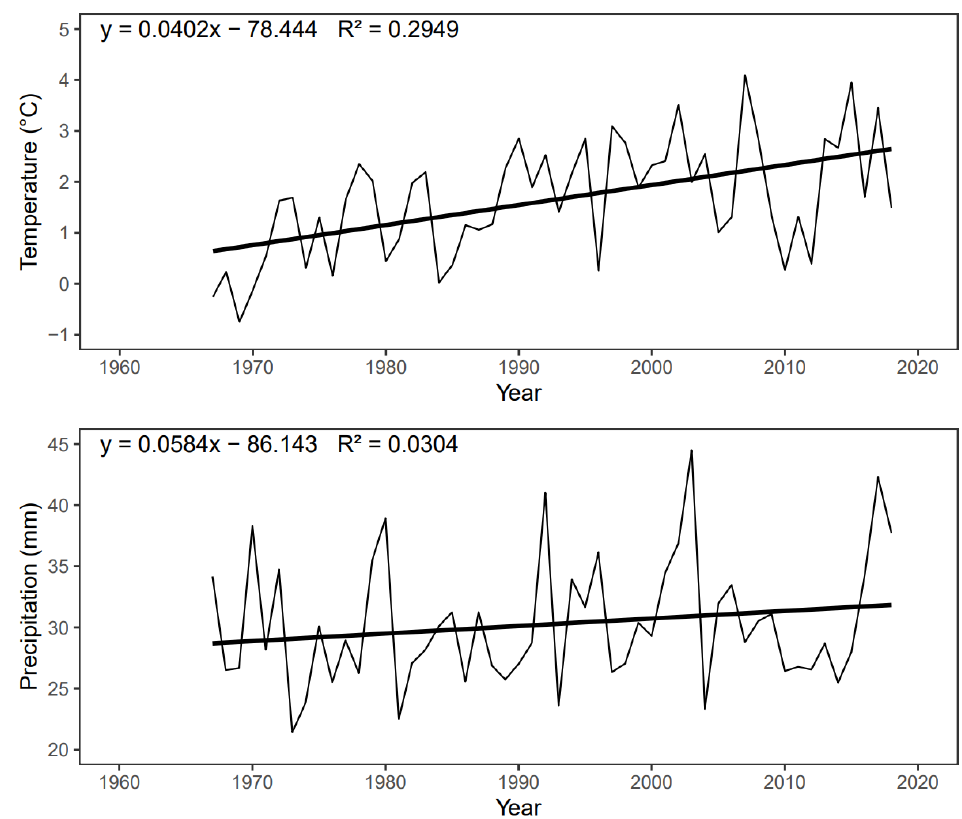
Figure 3. Annual mean temperature and annual precipitation from the Minusinsk weather station from 1966 to 2018.